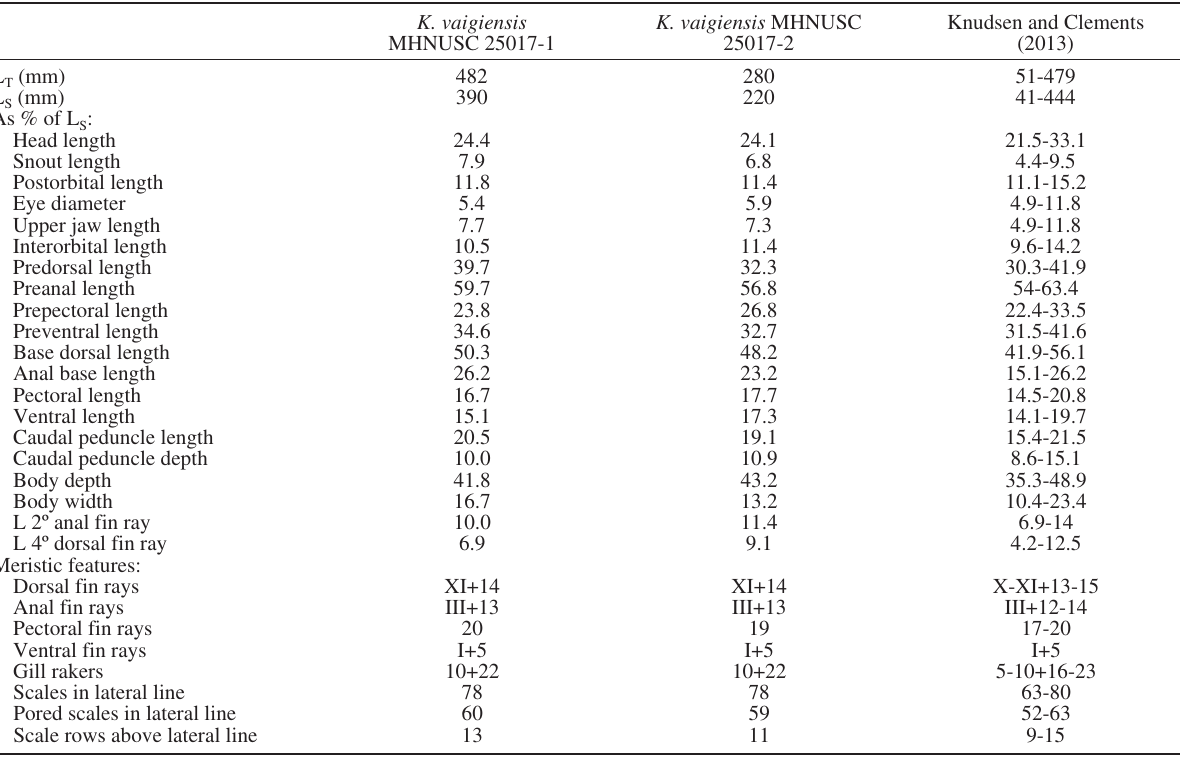
Table 3. – Morphometric and meristic data of K. vaigiensis specimens caught in Galician